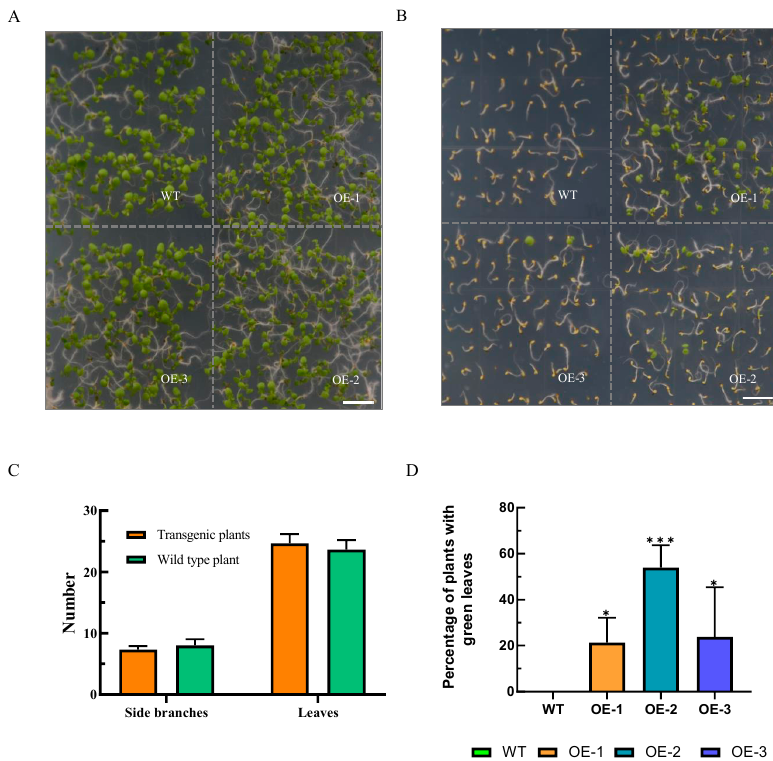
Figure 3. LcMKK2 -overexpressing Arabidopsis ( LcMKK2-OE ) plants are more salt-tolerant than the wild-type (WT) plants. ( A ) Plants germinating on ½ MS medium for 7 days. ( B ) Plants germinating on 100 mM NaCl salt medium for 7 days. ( C ) Quantification of the number of side branches and leaves developed by wild-type and LcMKK2-OE plants under soil conditions. ( D ) Quantification of the percentage of plants developing green leaves in ( B ). *** p < 0.001; * p < 0.05. ANOVA test was performed for statistical analysis. Data represent means ± SD from three technical replicates. Scale bar = 1 cm.